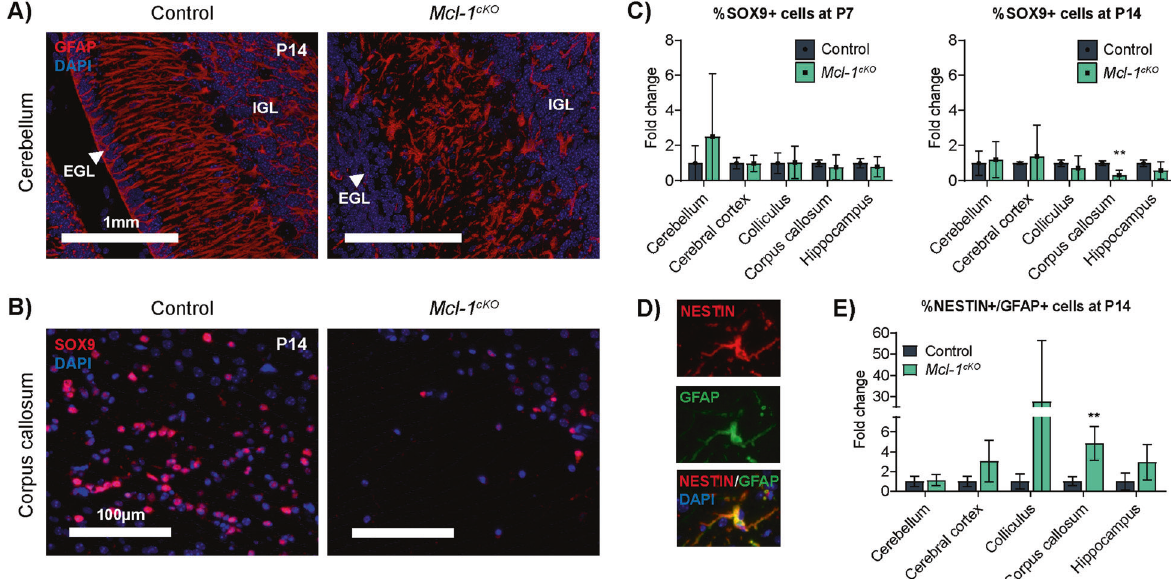
Fig. 6 Mcl-1 deletion causes reactive astrocytosis. A Representative GFAP IHC in sections of P14 cerebella in the indicated genotypes shows Bergmann glia processes in the control mice that are absent in the Mcl-1 cKO and numerous astrocyte processes in the Mcl-1 cKO mice. B Representative SOX9 IHC in sections of P14 corpus callosum in the indicated genotypes show a signi fi cant decrease of SOX9 + cells in the Mcl-1 cKO mice. C Quanti fi cation of SOX9 IHC at the indicated ages and genotypes, showing that astrocyte numbers are not increased in Mcl- 1 cKO mice. D , E NESTIN/GFAP IHC, with representative images and quanti fi cation in the indicated genotypes. **denotes p < 0.01 relative to